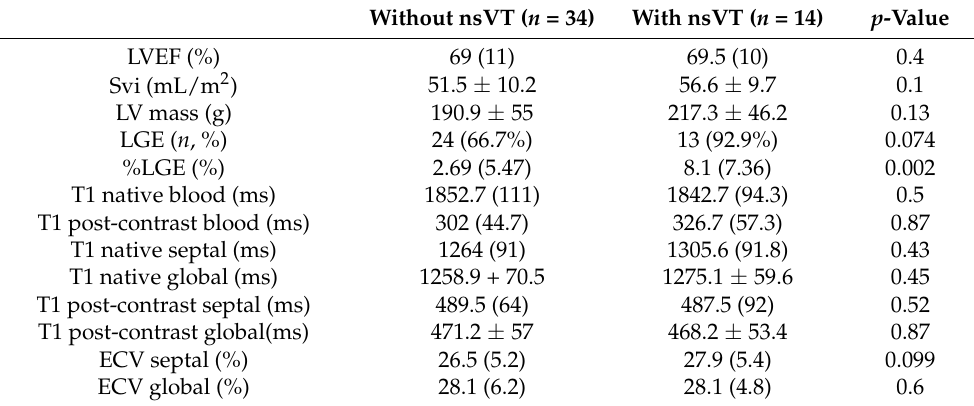
Table 2. Comparison of CMR findings between HCM patients with and without nsVT.